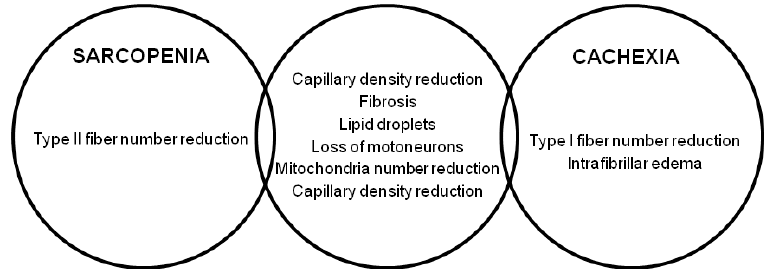
Figure 1. Skeletal muscle histological alterations in sarcopenia and cachexia adapted from von Haehling et al. [4].